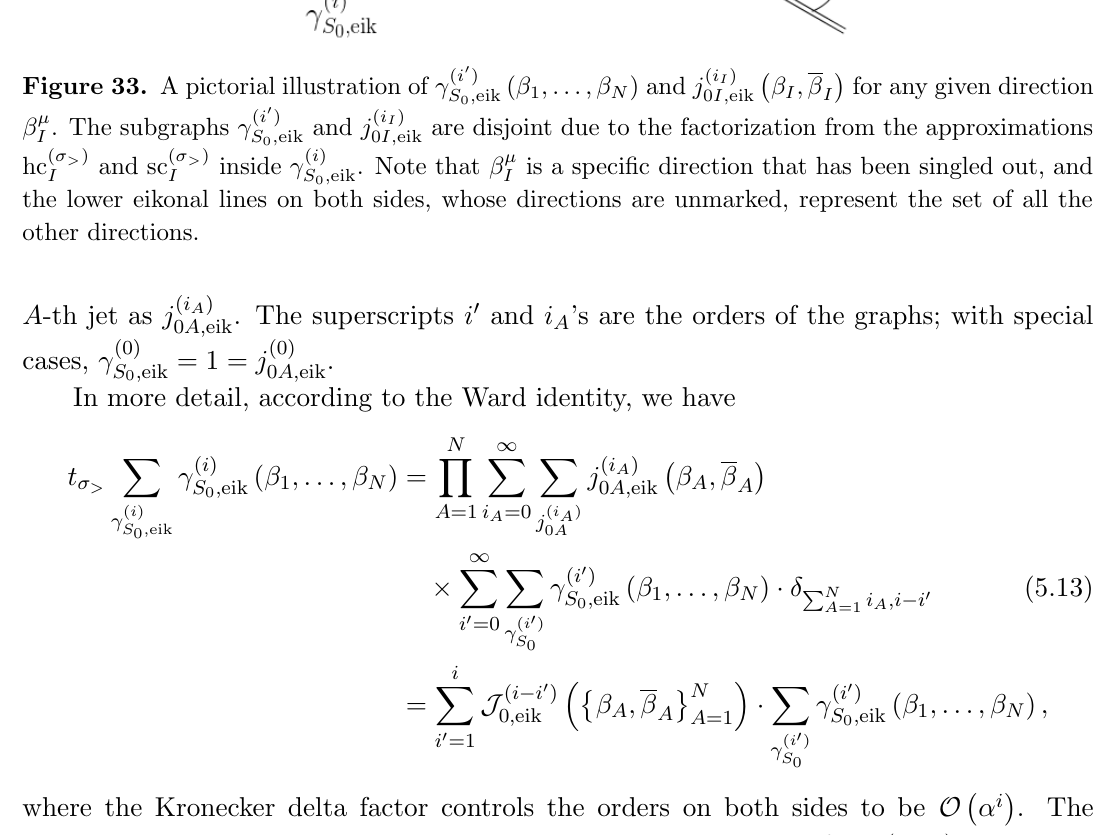
(cid:0) (cid:1) (cid:12) I ; (cid:12) for any given direction I 0 I; eik